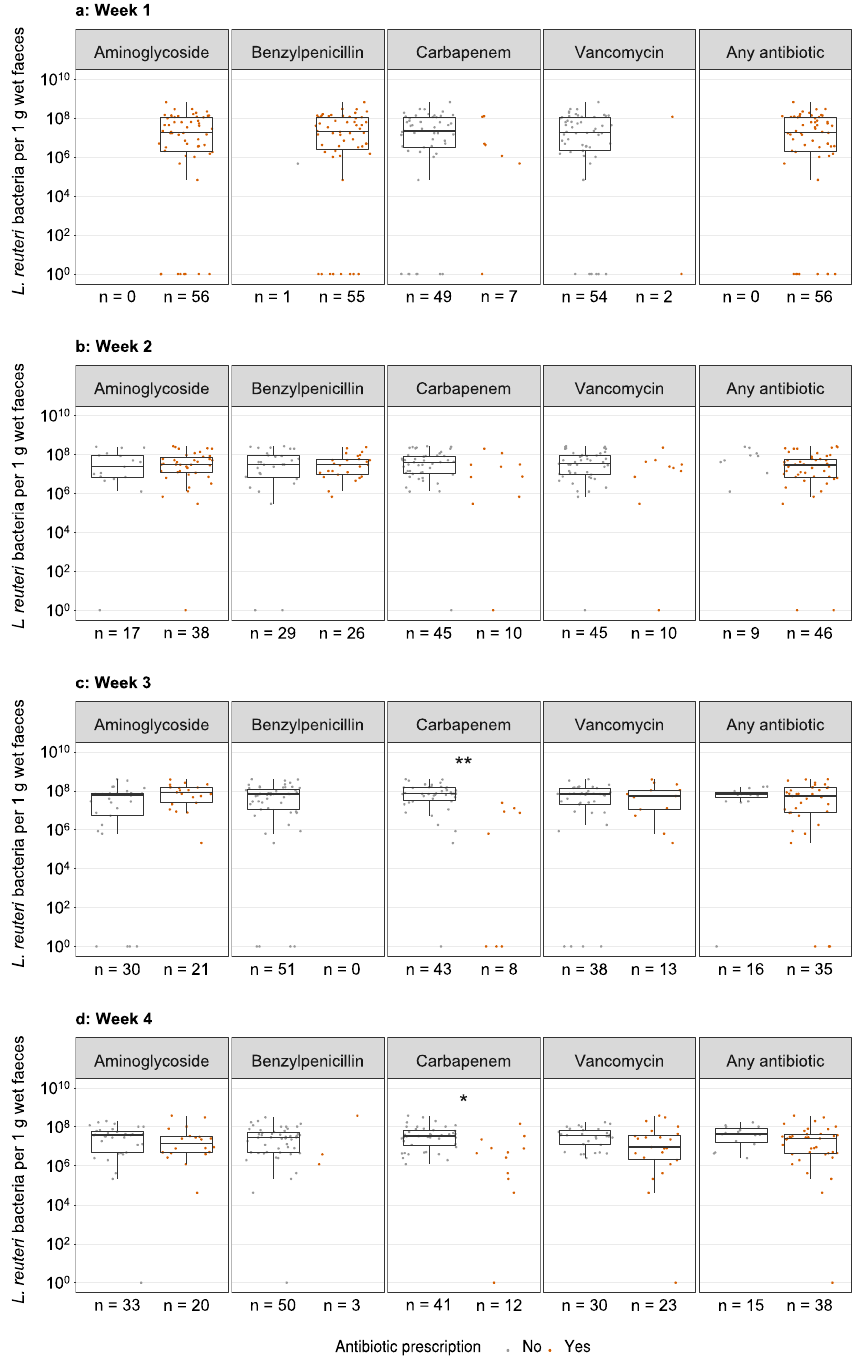
Figure 4. Antibiotic treatment and L. reuteri abundance in faeces of the L. reuteri -supplemented group. L. reuteri abundance in faeces of L. reuteri -supplemented extremely preterm ELBW infants at one ( a ), two ( b ), three ( c ), and four ( d ) weeks of age, who were not (grey dots) or were (red dots) treated with antibiotics for at least one day during the week preceding faecal sampling. Abundance is expressed as L. reuteri bacteria per 1 g wet faeces. Boxplots show median with 25% and 75% percentiles and 1.5 × the interquartile range. For graphical display, the number of L. reuteri bacteria per 1 g wet faeces was set to 10 0 for infants with L. reuteri -negative faeces. Numbers below the panels indicate the number of infants in the respective group. This figure only shows antibiotics, for which the sample size at any week was at least 10, while data on less common antibiotics are presented in Table S5. Statistics: Mann–Whitney U test with Benjamini–Hochberg correction. * adjusted p < 0.05, ** adjusted p < 0.01. ELBW = extremely low birth